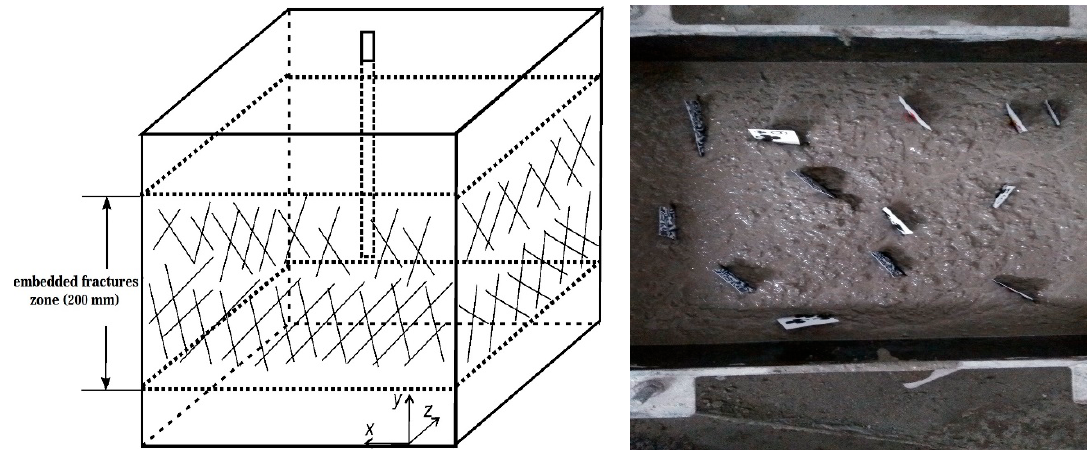
Figure 8. Schematic of the sample with embedded fractures ( left ) and the inserted clipped cards ( right ).